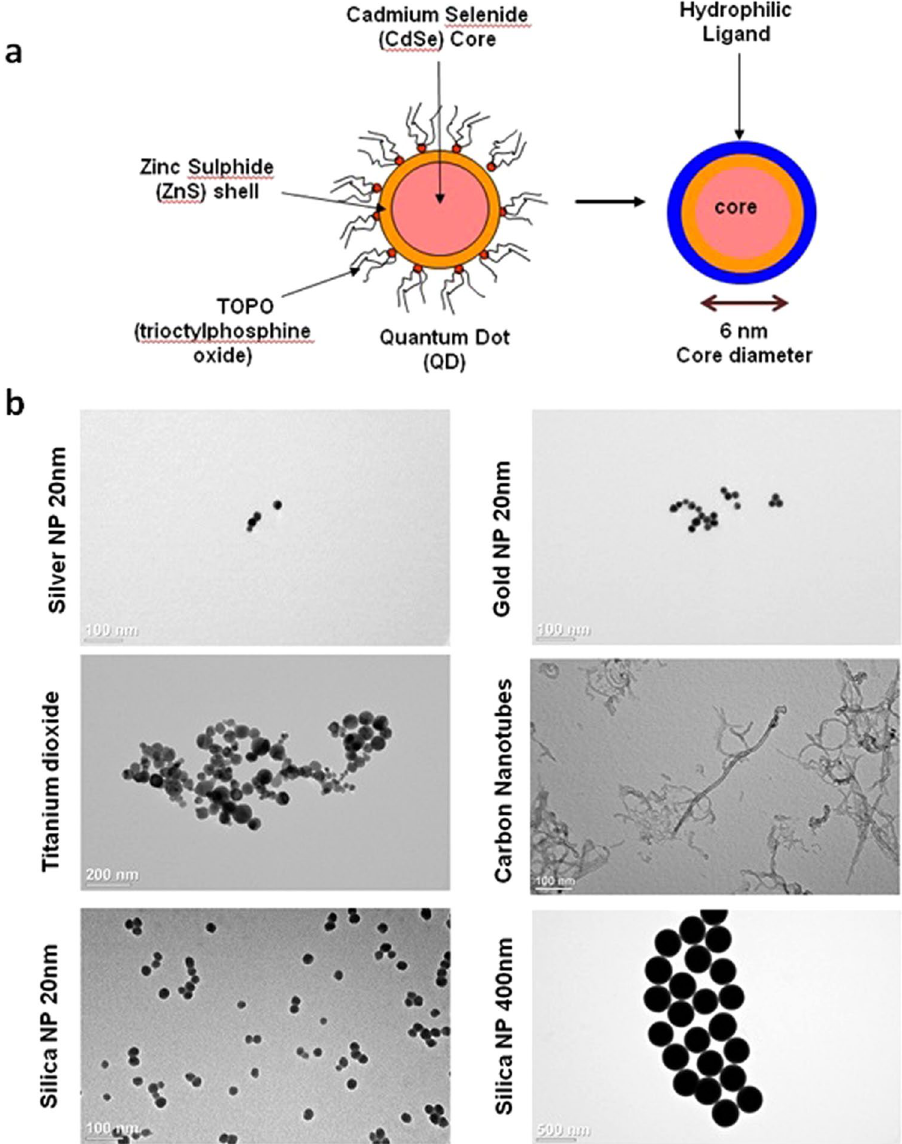
Figure 2. Quantum dot preparation and nanoparticle characterization. ( a ) Schematic demonstrating the ligand exchange method used to alter the surface coating on commercial QDs. Ligand exchange methods are used to coat QD with hydrophilic ligands to make them water soluble and to alter surface charge. ( b ) Characterization of NPs using Transmission Electron Microscopy (TEM). TEM was used to qualitatively evaluate NP size and agglomeration of various NPs purchased from